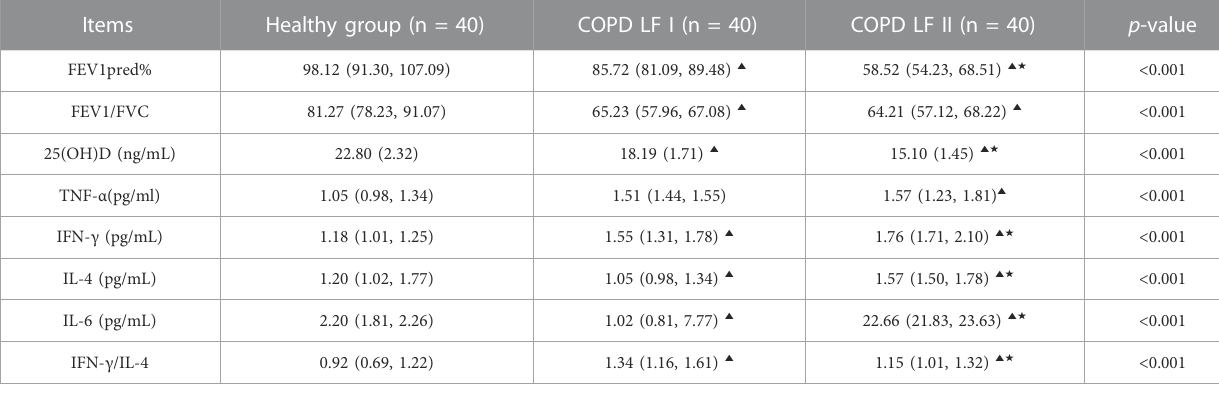
TABLE 2 Comparison of lung function-related indexes, 25(OH)D levels, cytokines, and Th1/Th2 among the three groups.